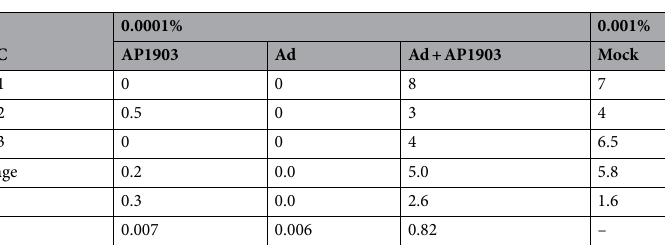
Table 1. Number of detected hiPSC colonies per well in the three independent experiments shown in Fig. 3. The number of hiPSC colonies per well in the experiments is shown as means (2 wells), except for the 0.0001% hiPSC group treated with both the Ad vector and AP1903 (1 well). The average and SD were calculated from the data of three independent experiments. The P values were analyzed by one-way repeated measures ANOVA and Dunnett’s post-hoc test ( vs. mock of 0.001% hiPSC, SigmaPlot Version